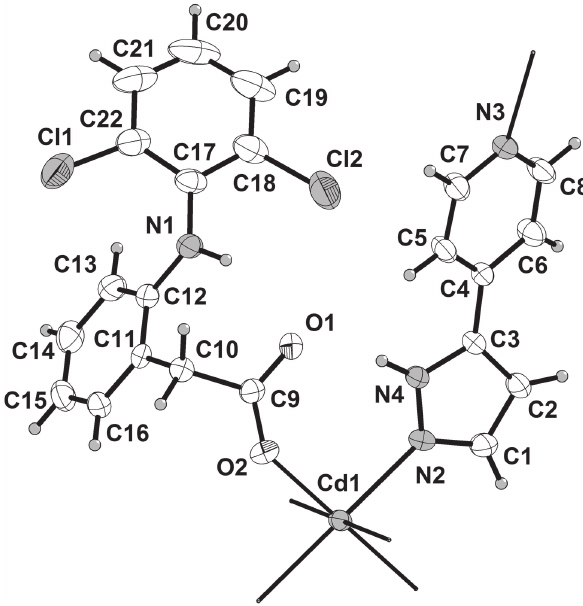
Table 1: Data collection and